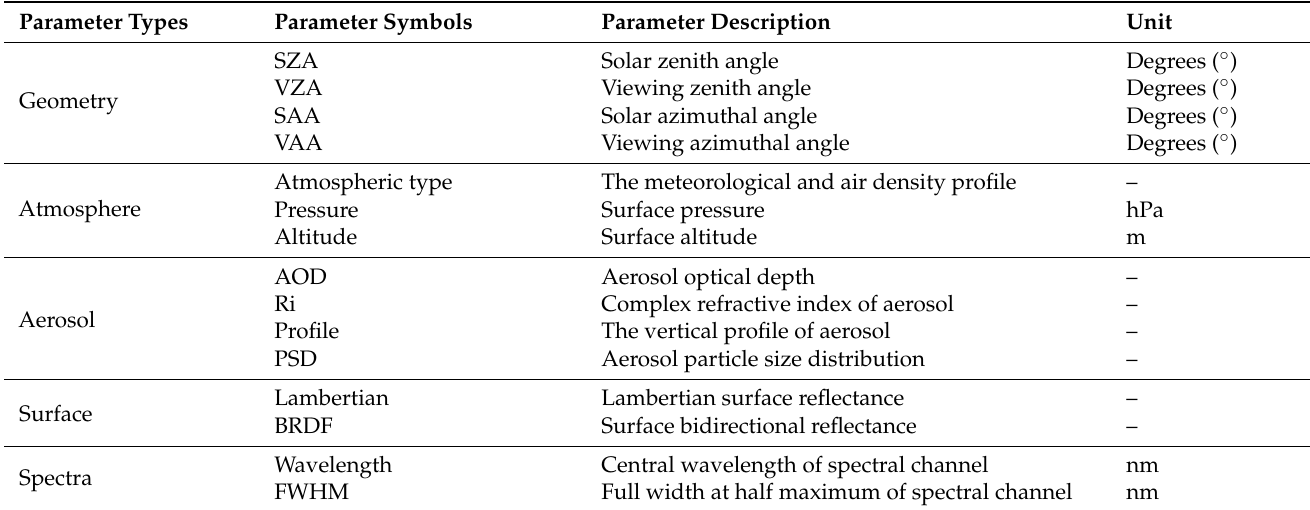
Table 1. Main input parameters of the UNL-VRTM